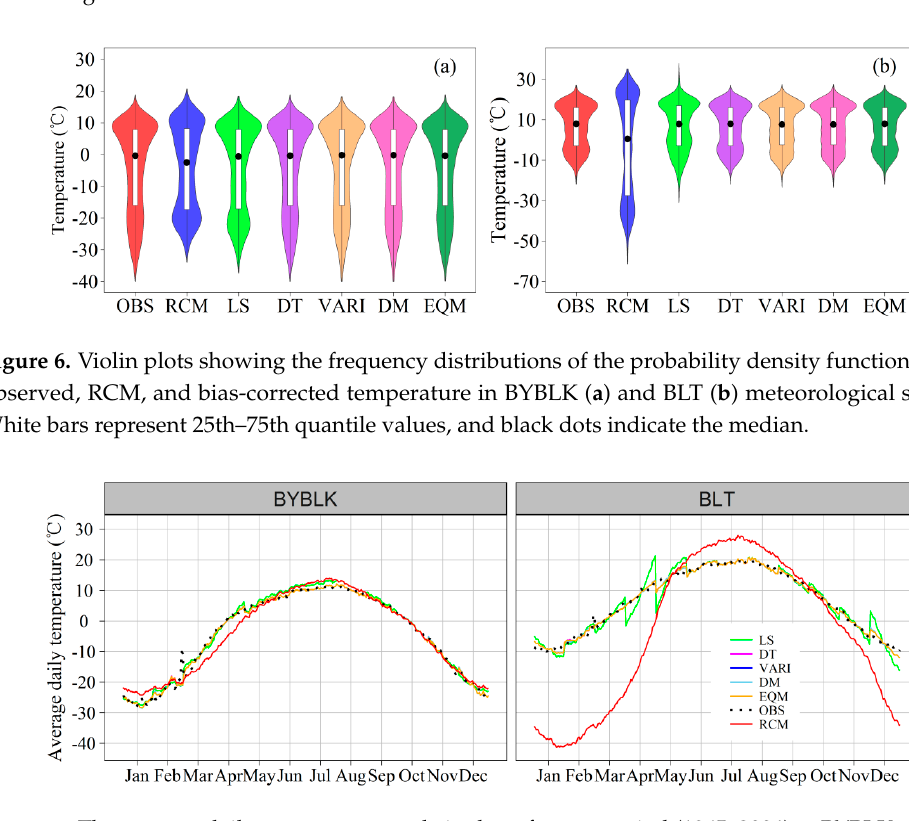
Figure 5. The average daily precipitation cycle in the reference period (1965–2004) at BYBLK and BLT meteorological stations.